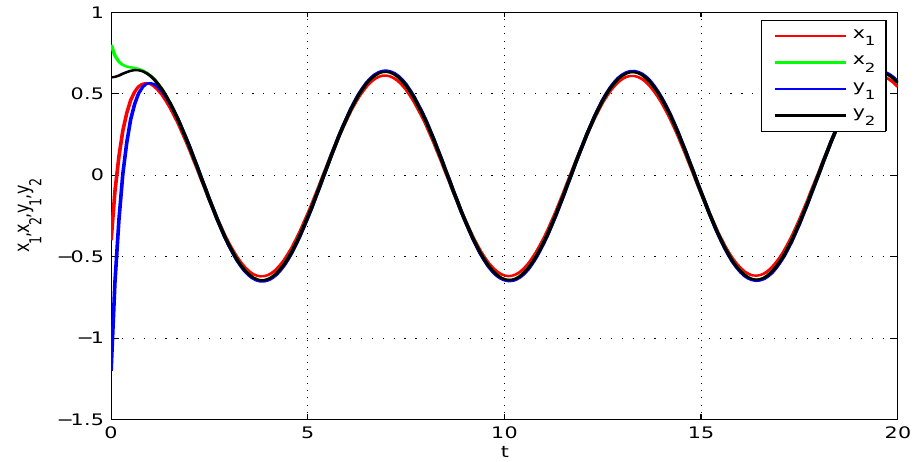
Figure 9. An illustration of the time responses with respect to the real and imaginary parts of the states p 1 and p 2 pertaining to the model in (13) in a 2 D space, in which ˜ u ( t ) = sin ( 0.02 t ) e − 0.005 t in Example